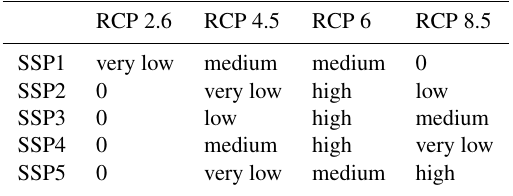
Table 3. Conditional probabilities (ranging from very low to very high) of SSPs resulting in RCPs based on authors’ judgement.